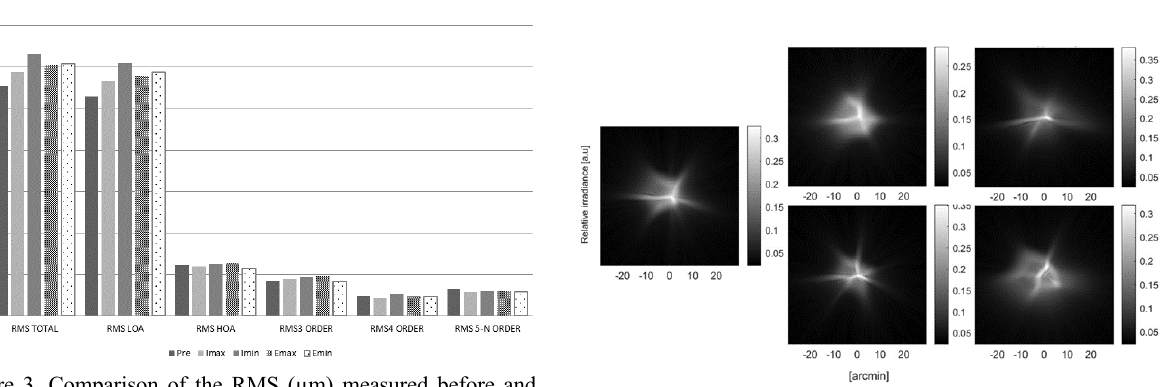
Figure 3. Comparison of the RMS (µm) measured before and after reading with e-ink reader and iPad in maximum and minimum lighting conditions. Baseline o previous (Pre) in black, iPad with maximum lighting conditions (Imax) in light grey, iPad with minimum lighting conditions (Imin) in dark grey, Ebook with maximum lighting conditions (Emax) in dark dotted, Ebook with minimum lighting conditions (Emin) in light dotted.